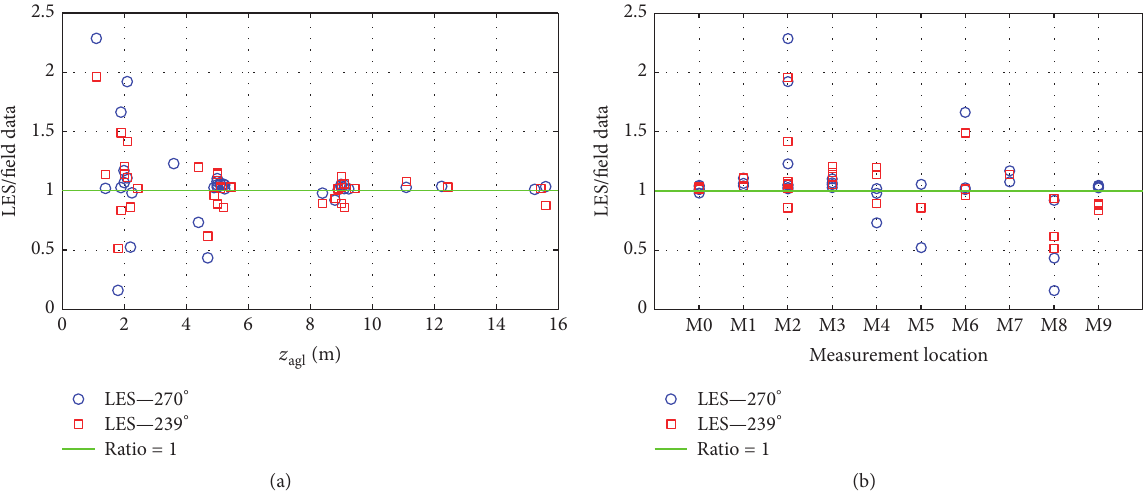
Figure 7:Ratio of LES tofield data for the normalized velocitymagnitude 𝑆/𝑢 ∗0 . The results fromboth wind directions are sorted with respect (a) and the mast measurement locations to the height above the ground level 𝑧 agl